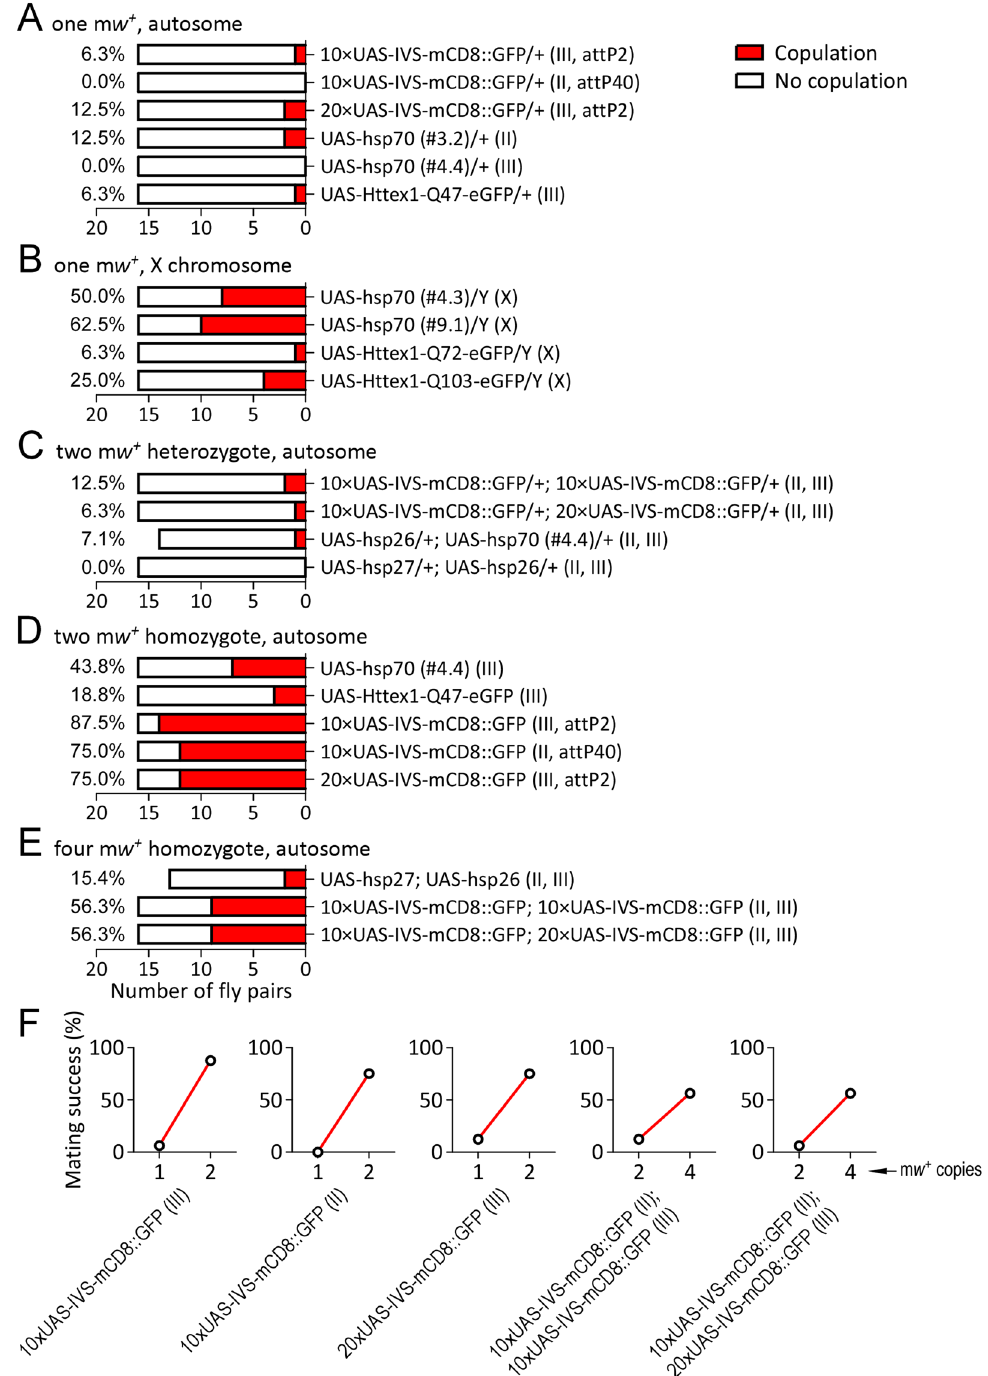
Figure 4. m w + rescued the defect of copulation success in w 1118 flies. ( A ) Copulation success (red bar) in flies carrying one copy of m w + on the autosome. The X axis denotes the number of fly pairs (sample size). Values of percent copulation success are provided. ( B ) Copulation success in flies carrying one copy of m w + on the X chromosome. ( C ) Copulation success in flies carrying two heterozygous m w + (two m w + heterozygotes) on the autosomes. ( D ) Copulation success in flies carrying homozygous m w + (two m w + homozygotes) on the autosomes. ( E ) Copulation success in flies carrying double homozygous m w + (four m w + homozygotes) on the autosomes. ( F ) Correlations of copulation success between heterozygous and homozygous flies carrying the same transposons. Numbers indicate m w + copies on the autosomes. Chromosomal locations of m w + are indicated in the parentheses. attP2: site-specific recombination site on the third chromosome; attP40: site- specific recombination site on the second